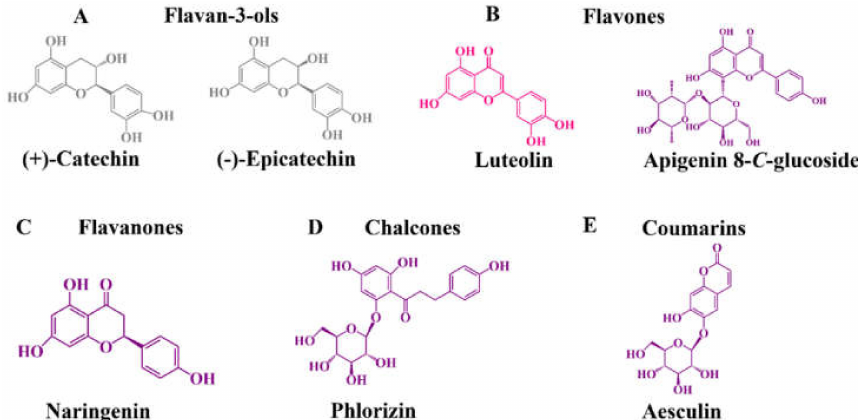
Figure 4. Main flavan-3-ols ( A ), flavones ( B ), flavanones ( C ), chalcones ( D ), and coumarins ( E ) re- ported in both cherries and blueberries (grey color), sweet cherries (pink color), and highbush blueberries (purple color). (Figure created with ChemDraw Professional 16.0 (CambridgeSoft, Perkin Elmer Inc., Waltham, MA,